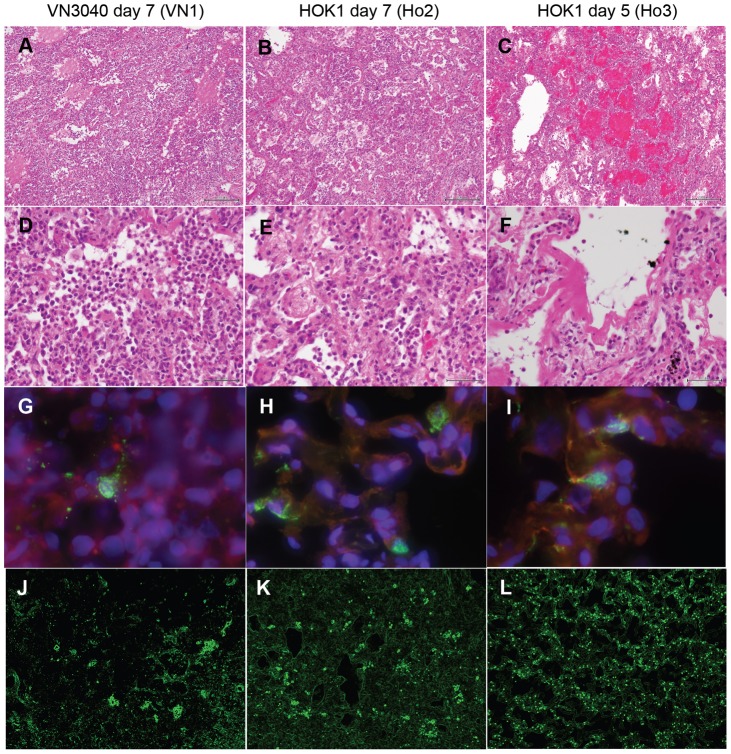
Viral pneumonia in macaques infected with H5N1 highly pathogenic avian influenza virus.One macaque, VN1 (A, D, G, J), was inoculated with VN3040. Two macaques, Ho2 (B, E, H, K) and Ho3 (C, F, I, L), were inoculated with HOK1. VN1 and Ho2 were autopsied 7 days after virus inoculation. The dead macaque Ho3 was autopsied 5 days after virus infection. (A–F) Lung tissue sections were stained with H & E. A–C: low magnification (bars: 200 µm), D–F: high magnification (bars: 50 µm). (G–I) Viral antigen was stained with FITC-conjugated anti-influenza A virus antibody (green) in combination with eFluor615-conjugated cytokeratin (red) and DAPI for staining of nuclei (blue). (J–L) The distribution of viral antigen in lungs stained with FITC-conjugated anti-influenza A virus antibody (bright green). The images were analyzed under a sobel edge detection filter.